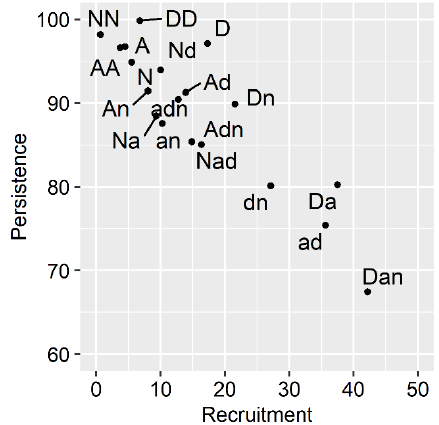
Figure 3. Persistence and recruitment of CONUS land area by landscape mosaic class. Persistence is the percentage of 2001 area that remained in that class until 2016, and recruitment is the percentage of 2016 area that was not in that class in 2001. Excludes water area.